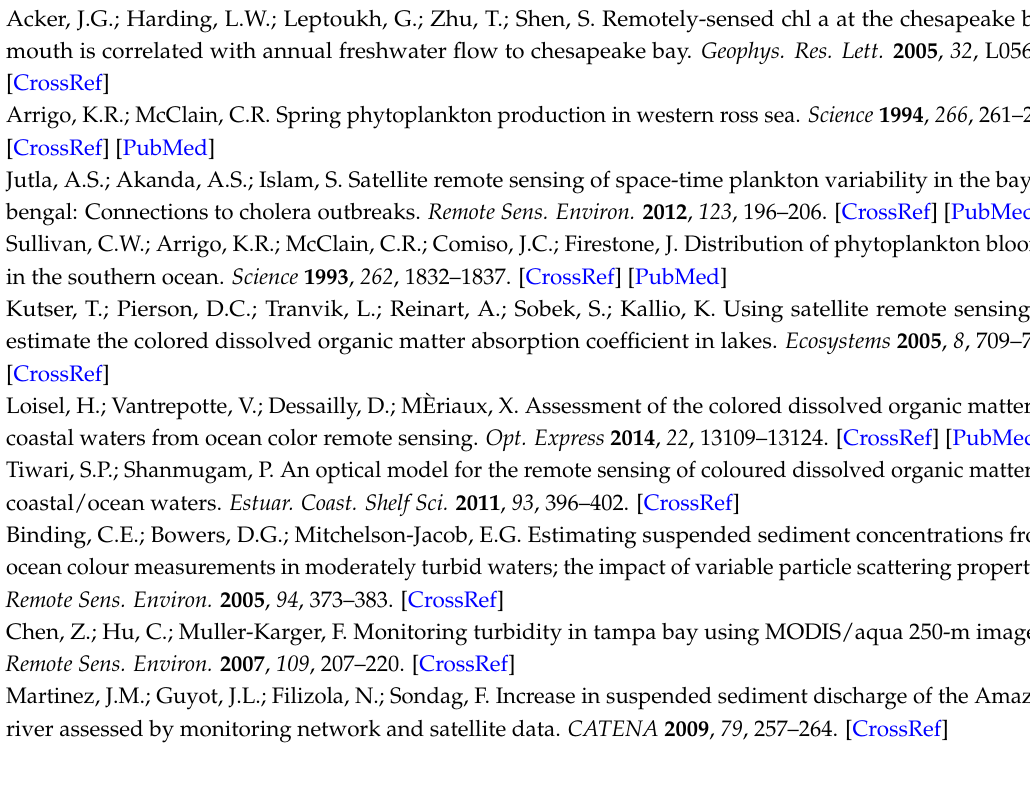
Figure S1: (a) Scatter plot for modelled and HydroLight ω 1 Figure S2: (a) Scatter plot for modelled and HydroLight ω 1 Six different water types grouped based on CHL concentration and CDOM, Table S2: Comparative ω 1 results for the NRP and SASM models (all p < 0.005), Table S3: Comparative ω 1 and SASM models (all p < 0.005), Table S4: Comparative ω 1 p < 0.005), Table S5: Comparative (790 nm) results for the NRP and SASM models (all p <